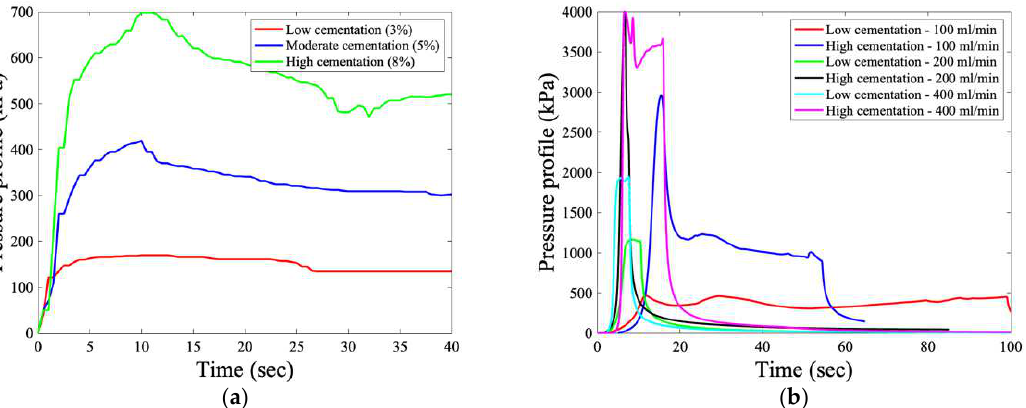
Figure 4. Pressure profiles obtained during glycerine injection experiments: ( a ) for three specimens at low (3%), moderate (5%), and high cementation (8%) levels at 30 mL/min, and ( b ) for the lowest (3%) and highest (8%) cementation levels at flow rates of 100, 200, and 300 mL/min. The pressure profiles of the tests conducted with fine sands at higher flow rates (100, 200, and 400 mL/min) for the lowest and highest cementation level are shown in Figure 4b. The breakdown pressures increased substantially as the flow rate increased. At such high flow rates, once damage occurred within the specimens, the pressure decreased dras- tically across all cementation levels. This contrasts with the 30 mL/min pressure profiles, in which the breakdown and operating pressures were of the same